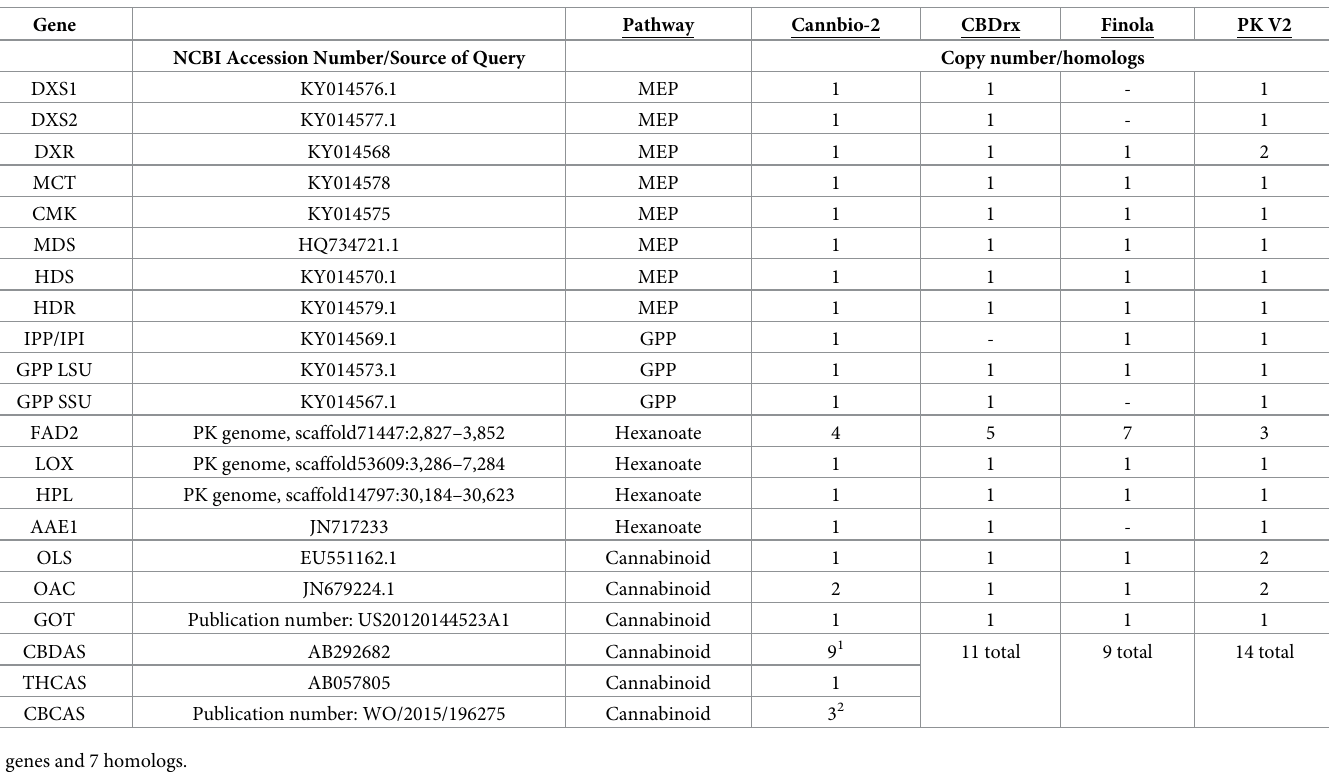
Table 1. Source of gene query/NCBI accession number and gene copy and homolog number for available genomes discovered using BLAST. Gene Pathway Cannbio-2 CBDrx Finola PK V2 NCBI Accession Number/Source of Query Copy number/homologs